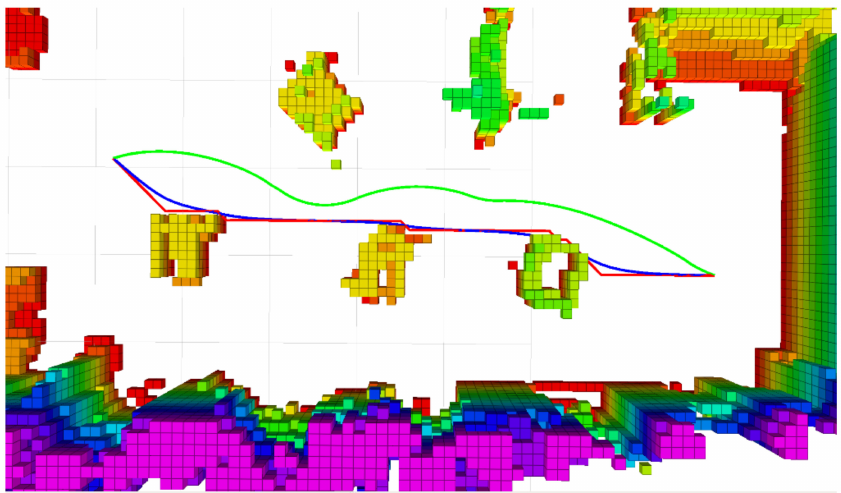
Figure 11. The paths generated by our proposed path-generation algorithm (green), the Path Smooth algorithm (blue), and the A* algorithm (red) in the